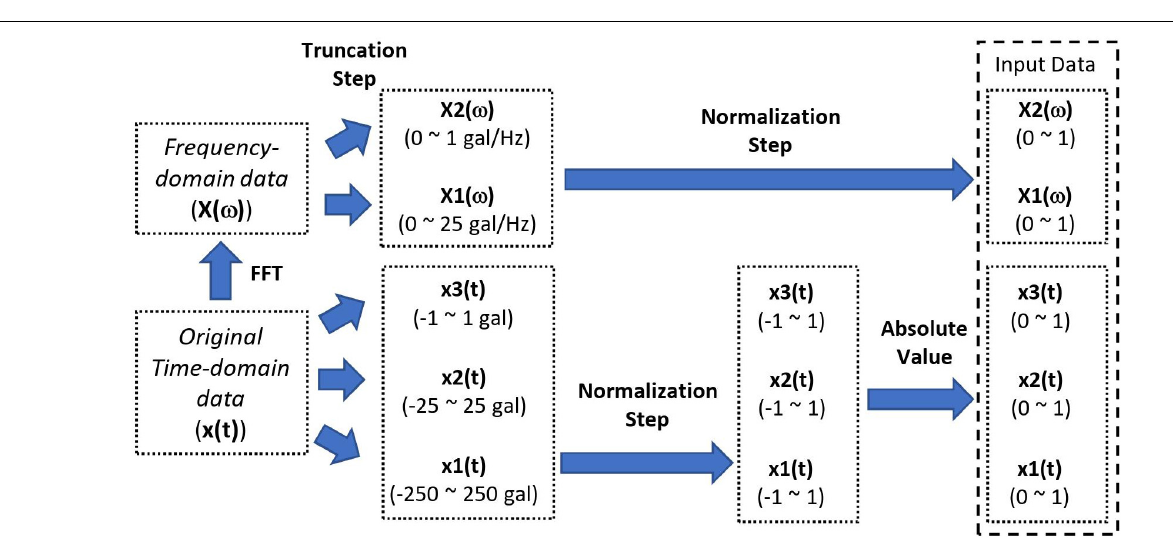
FIGURE 6 | The summarized procedures to obtain the multi-domain and multi-scale input for the